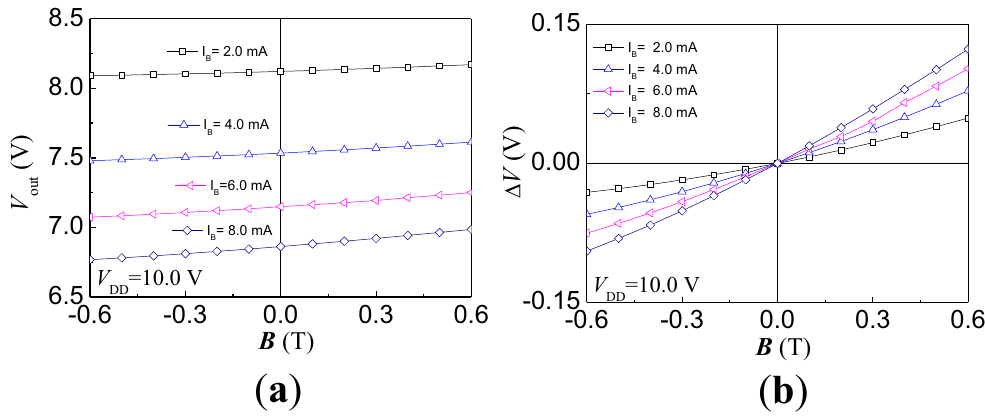
Figure 12. The magnetic characteristic curves of the HSMST chip: ( a ) Between V out and B ; ( b ) Between ∆ V and B .